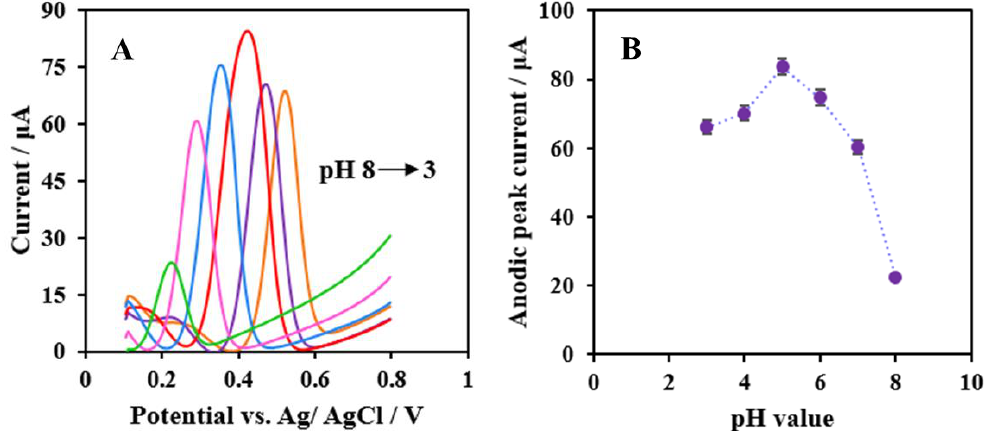
Figure 9. ( A ) Effects of different pH values on the CVs of NF/IL/CMC-MWCNTs/GCE in 50 mM PBS containing 5 μM rutin at a scan rate of 100 mV s −1 . ( B ) Plot of anodic-peak current vs. pH value.